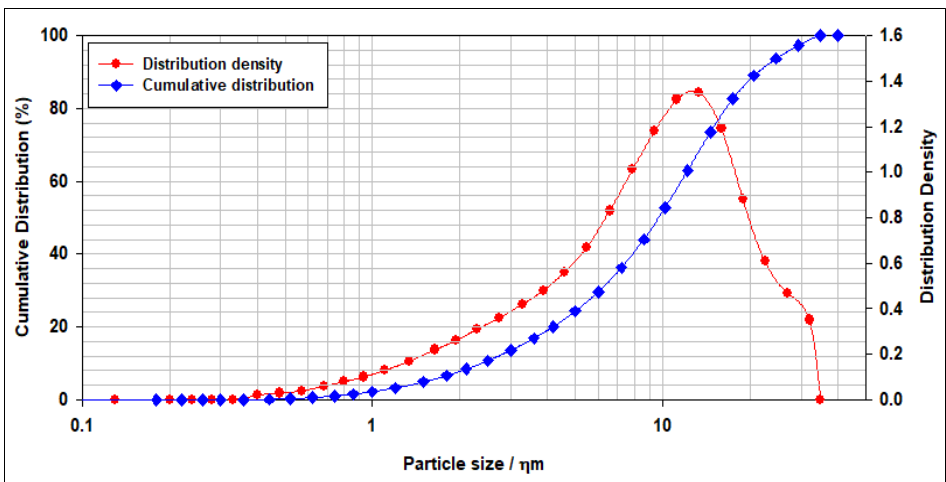
Figure 2. The particles size distribution of the nanoclay (NC) particles.